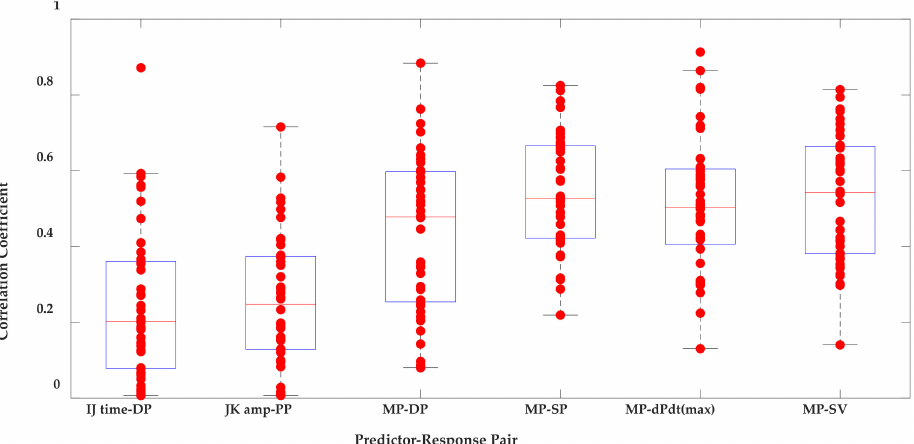
Figure 10. Boxplots of the correlation coefficients for the predictor–response pairs described in Table 3. using the BCGs measured from Film 0. MP: multiple parameters (IJ time, IJ amp, JK time, and JK